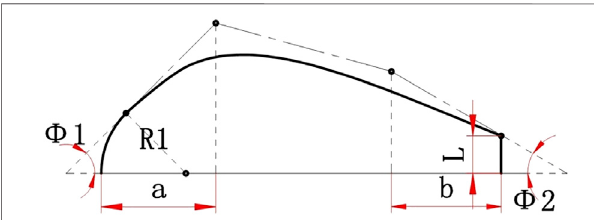
FIGURE 3 | Thickness distribution of blunt